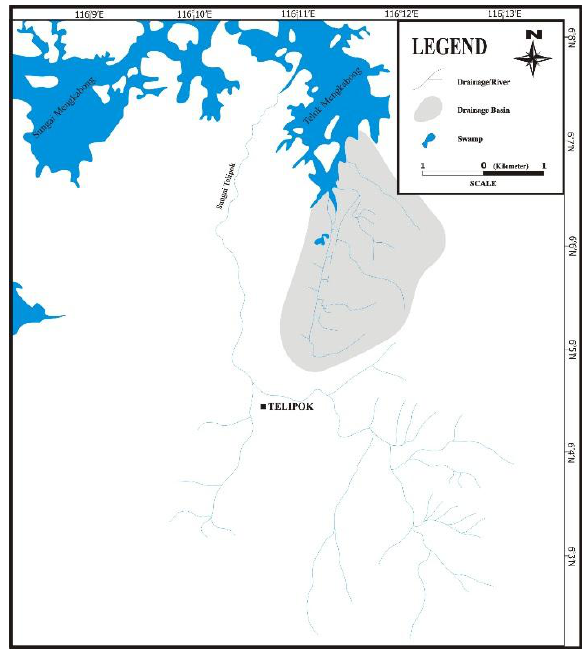
Figure 6: The ‘shoes - shape’ drai nage basin